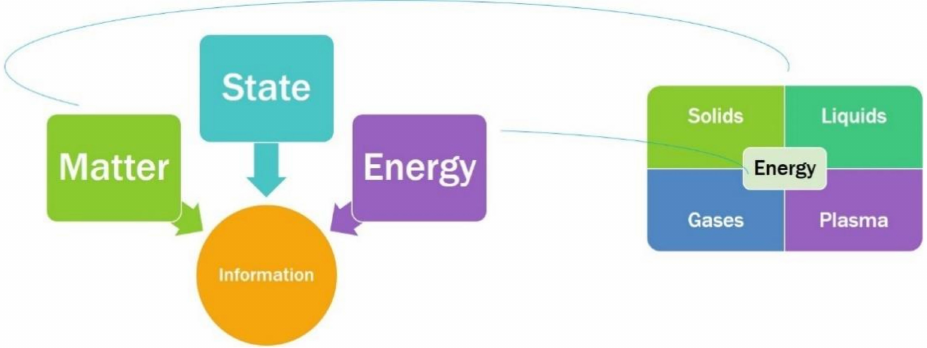
Figure 1. Theory of information trilogy—natural ecosystem view